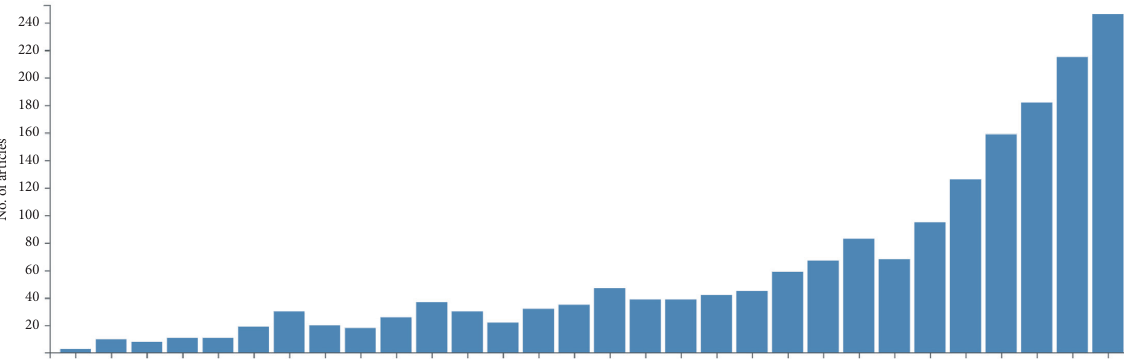
Figure 1: The number of articles on prefabricated buildings from 1990 to